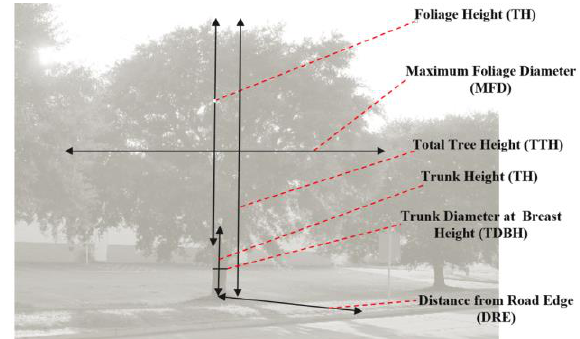
Figure 3. The characteristic feature of an individual tree (Safaie et al.,